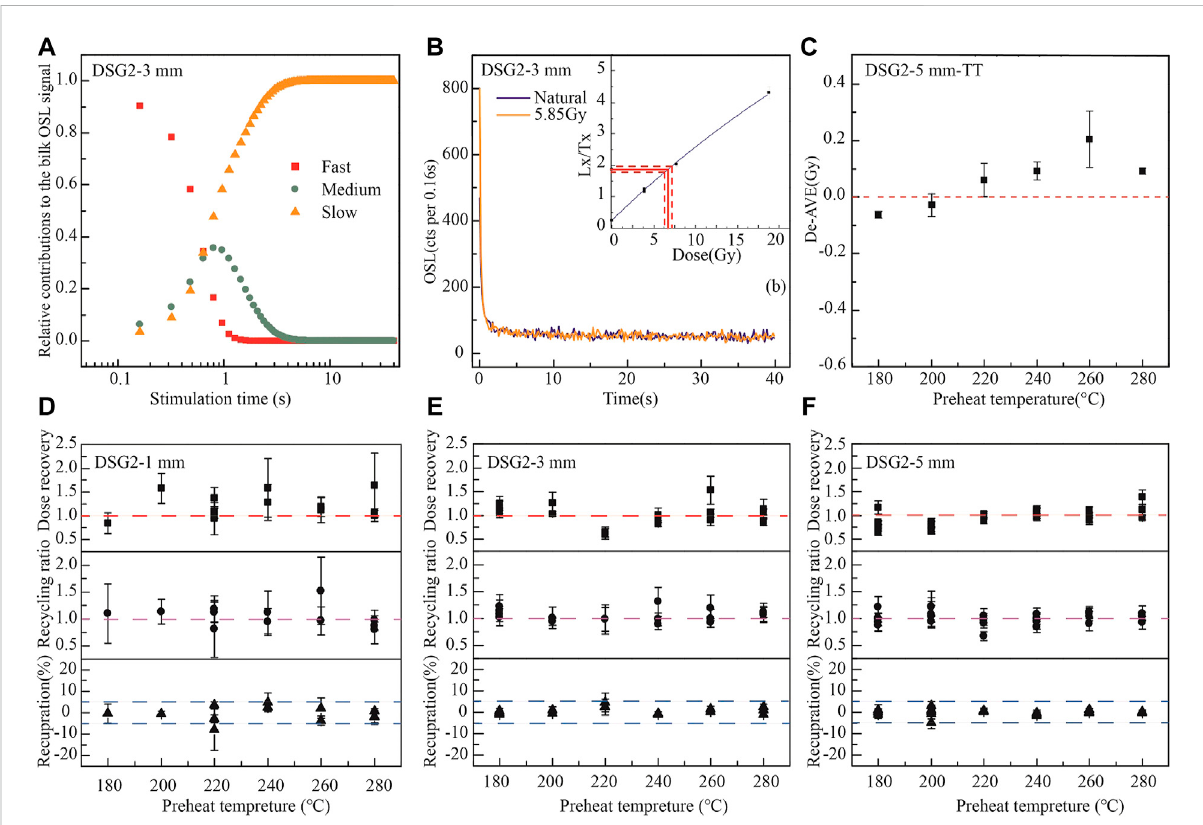
FIGURE 2 (A) Relative contributions from individual components to the bulk optically stimulated luminescence (OSL) signals as a function of the stimulationtimeforDSG2witha3-mmaliquot. (B) DecaycurveofDSG2andgrowthcurve(interpolated B ). (C)